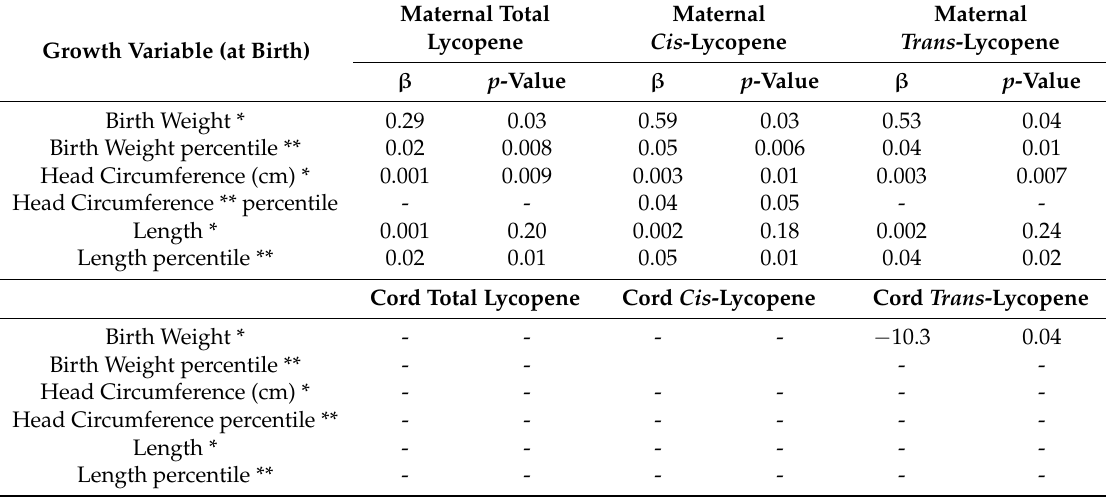
Table 3. Results of multivariate analysis for maternal serum concentrations of total lycopene and infant growth outcomes at birth after adjustment for gestational age, race, and maternal smoking (non-significant results not